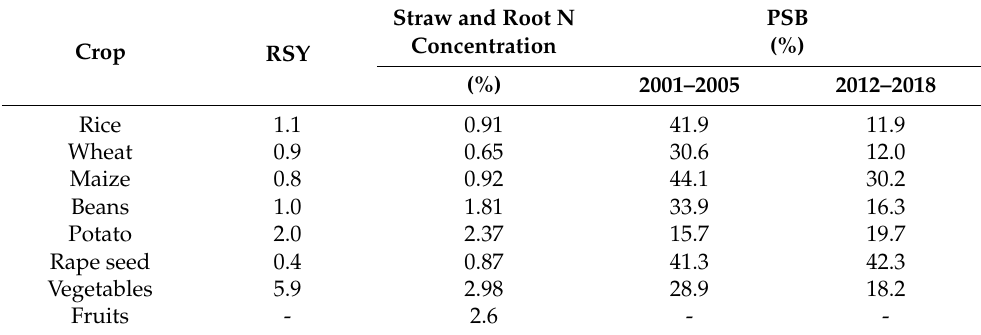
Table A5. Ratio of straw biomass to yield, the nitrogen concentration in crop straw (root) and return part to the total straw